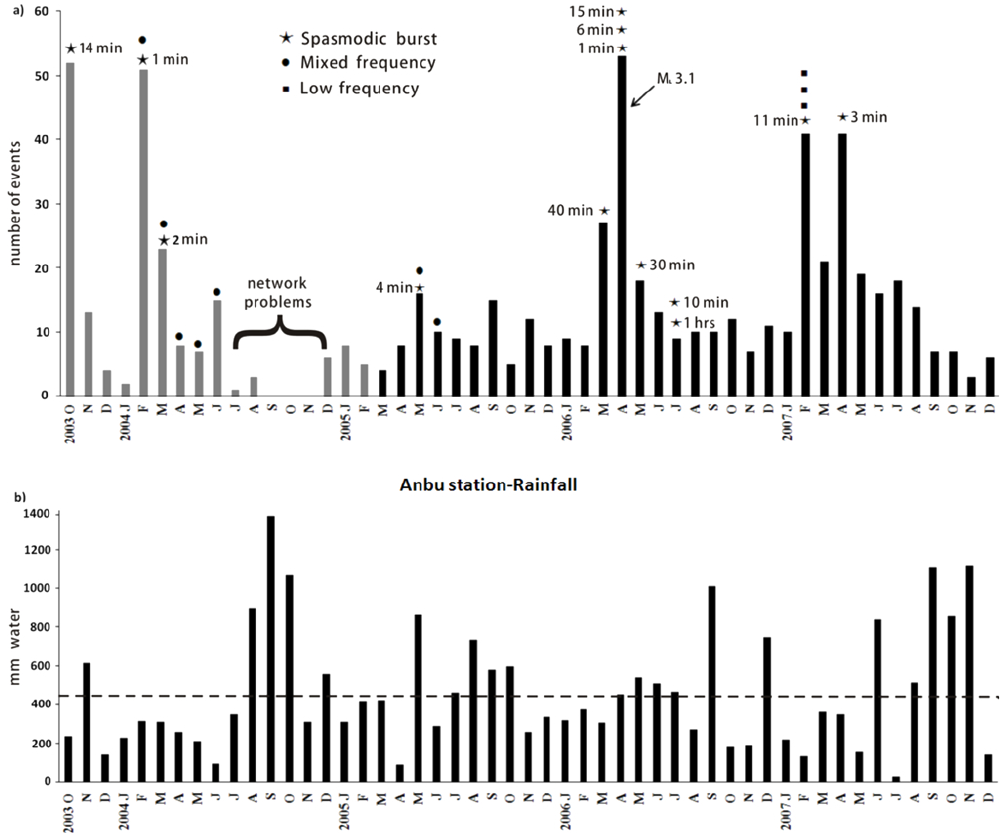
Fig. 4. (a) Histogram showing the temporal variation of the number of picked HF events per month for the whole of the observation period. The spasmodic burst (with their durations), mixed frequency and LF events are also indicated. The light gray bars indicate the events analyzed by Konstantinou et al. (2007). The almost zero number of events from July to December 2004 is due to network problems that did not allow a continuous recording of data at all stations, (b) rainfall levels for station ANBU, the nearest one to TVG. The black dashed line indicates the average level of rainfall (460mm) for the observed period.